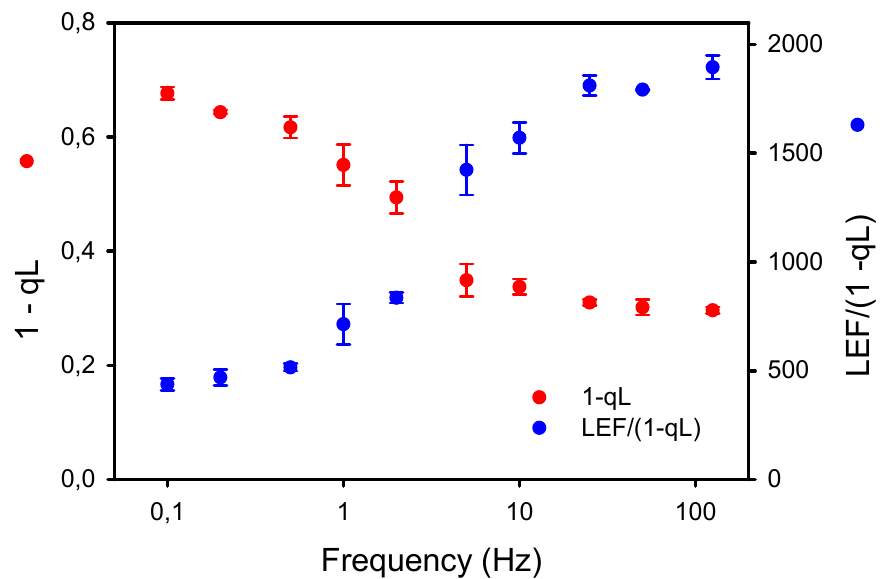
Figure 6. Opposite effects of the frequencies of pulsed lights on the apparent conductance of Cyt b 6 f to linear electron flow (LEF/(1-qL)) and the proportion of reduced plastoquinone PQH 2 (1-qL) estimated according to the diagnostic method of Johnson and Berry [34].